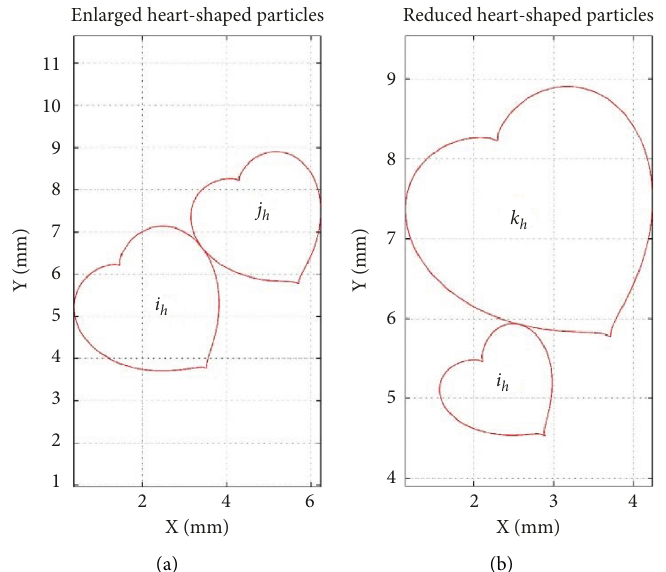
Figure 7: Contact detection of separated and overlapped heart-shaped particles. (a) Enlarged heart-shaped particles. (b) Reduced heart- shaped